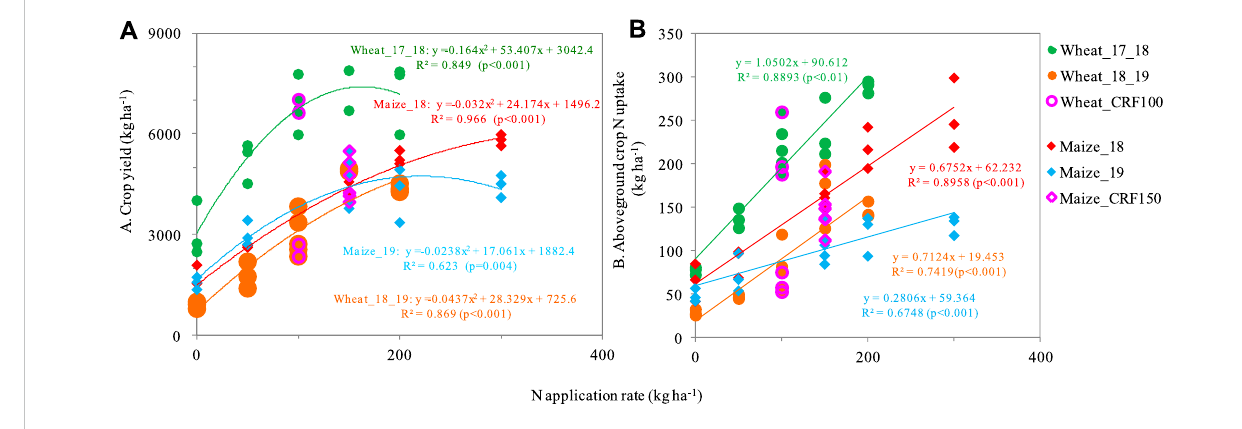
FIGURE 1 Responses of crop grain yield (A) and aboveground crop N uptake (B) to N fertilization rate and N fertilizer type.